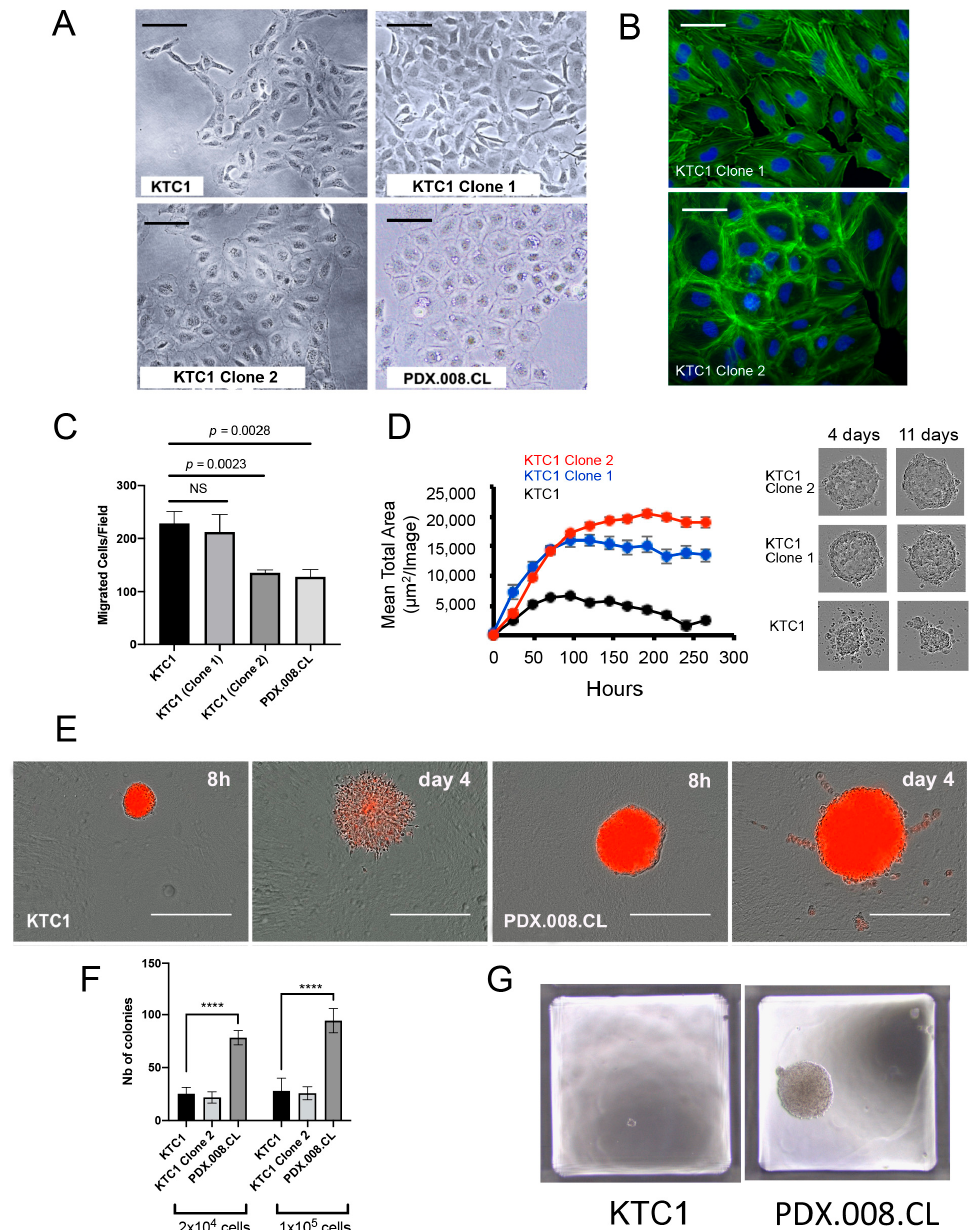
Figure 6. Effects of RAC1 gene amplification in KTC1 subclones. ( A ) There were noticeable shape differences between the original KTC1 cells and KTC1 cells Clone 2 harboring 4 RAC1 copies. In particular, similar to the PDX.008.CL cells, the KTC1 Clone 2 cells were round and flat and showed an increase in perinuclear vacuoles (bars = 50 µ m). ( B ) KTC1 cells Clone 1 showed the presence of actin stress fibers (green fluorescence) and a limited amount of cortical actin, while KTC1 Clone 2 showed striking actin reorganization into thick cortical actin bundles (bars = 20 µ m). ( C ) Migration assay data for KTC1 clones and PDX.008.CL cells demonstrated that RAC1 amplifications significantly impaired cell motility in 2D cultures ( n = 6). ( D ) KTC1 spheroid sizes significantly increased with RAC1 gene copy numbers as quantified with the IncuCyte platform (3D cultures, media without Matrigel). Phase contrast micrographs showed that control KTC1 spheroids broke apart after 4 days in culture while spheroids with excess RAC1 grew and remained stable for another 7 days. ( E ) KTC1 and PDX.008.CL cells were grown as spheroids in 3D Matrigel cultures. After 4 days, KTC1 cells distinctly expanded as single cells while the PDX.008.CL cells showed collective invasion, a feature of metastasis (bars 8 h = 300 µ m, bars day 4 = 150 µ m). ( F ) Equal numbers of KTC1 control cells